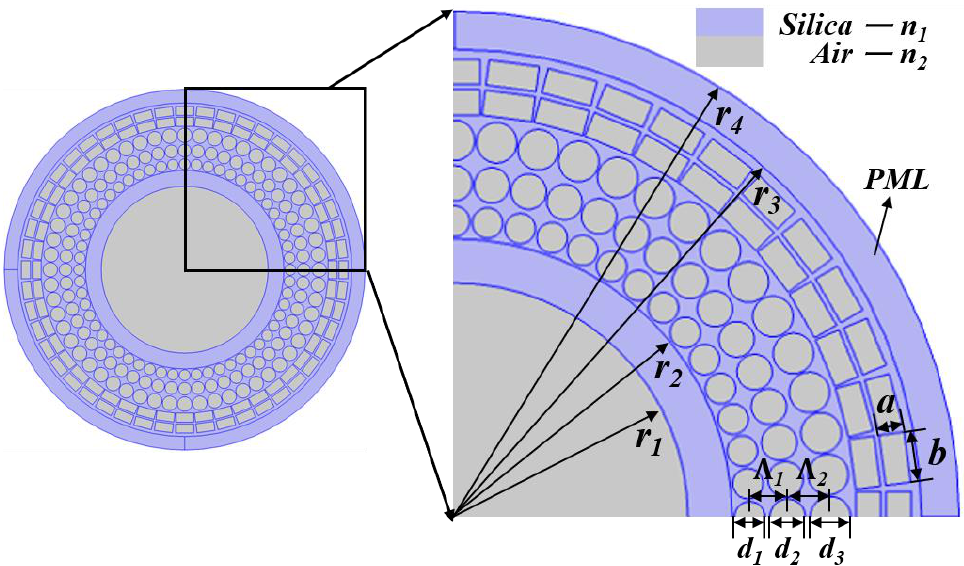
Figure 2. Cross-sectional diagram of a photonic crystal fiber.